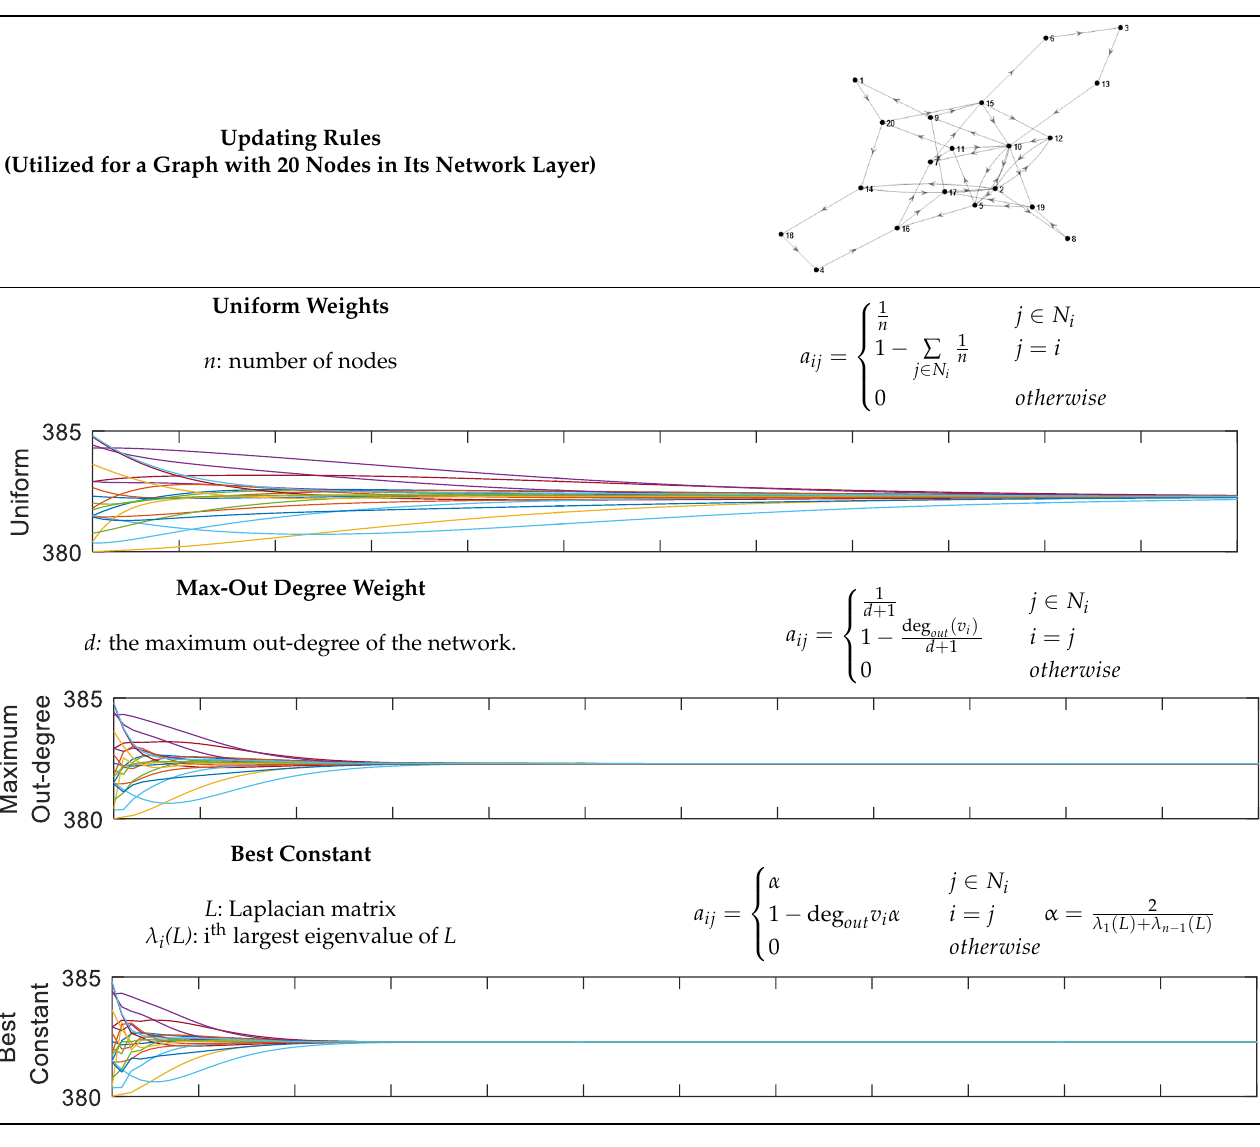
Table 2. Different Updating Rules Applied on a Graph with 20 Nodes [21].